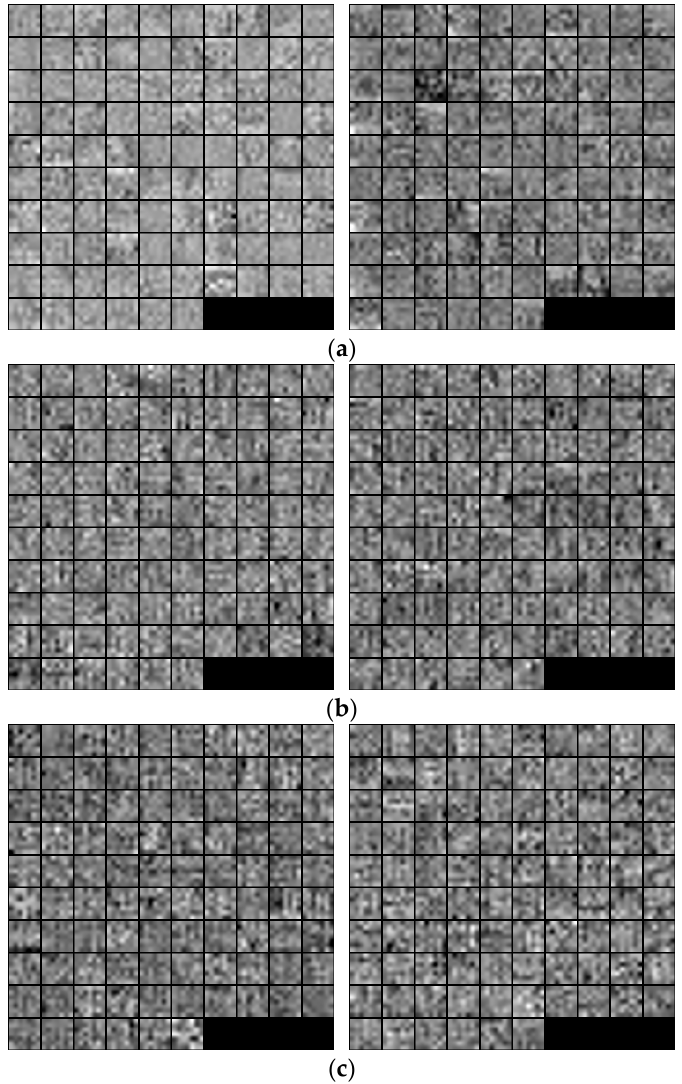
Figure 8. Visualization of filter parameters in the first convolutional layers of the CNN model in each national currency dataset, in which the left and right images are obtained from the trained models on the first and second subsets for two-fold cross-validation, respectively: ( a ) KRW; ( b ) INR; and ( c ) USD.